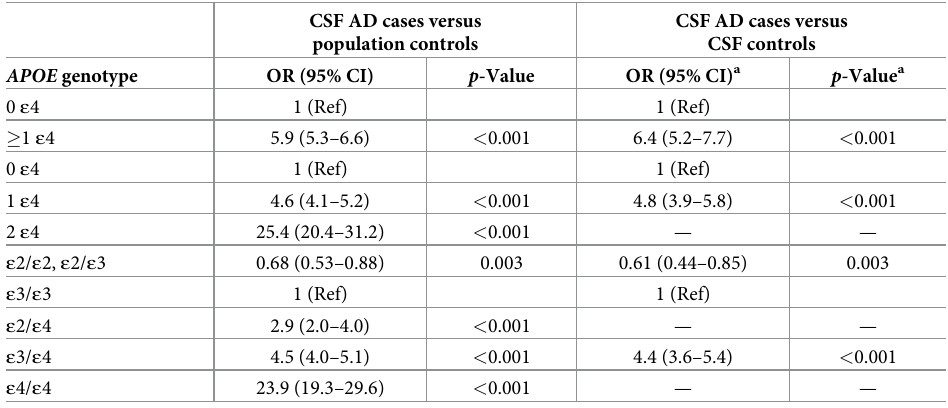
Table 2. The ORs of AD according to APOE genotype. CSF AD cases were compared with population controls and with CSF controls using logistic regression analysis. CSF AD cases versus population